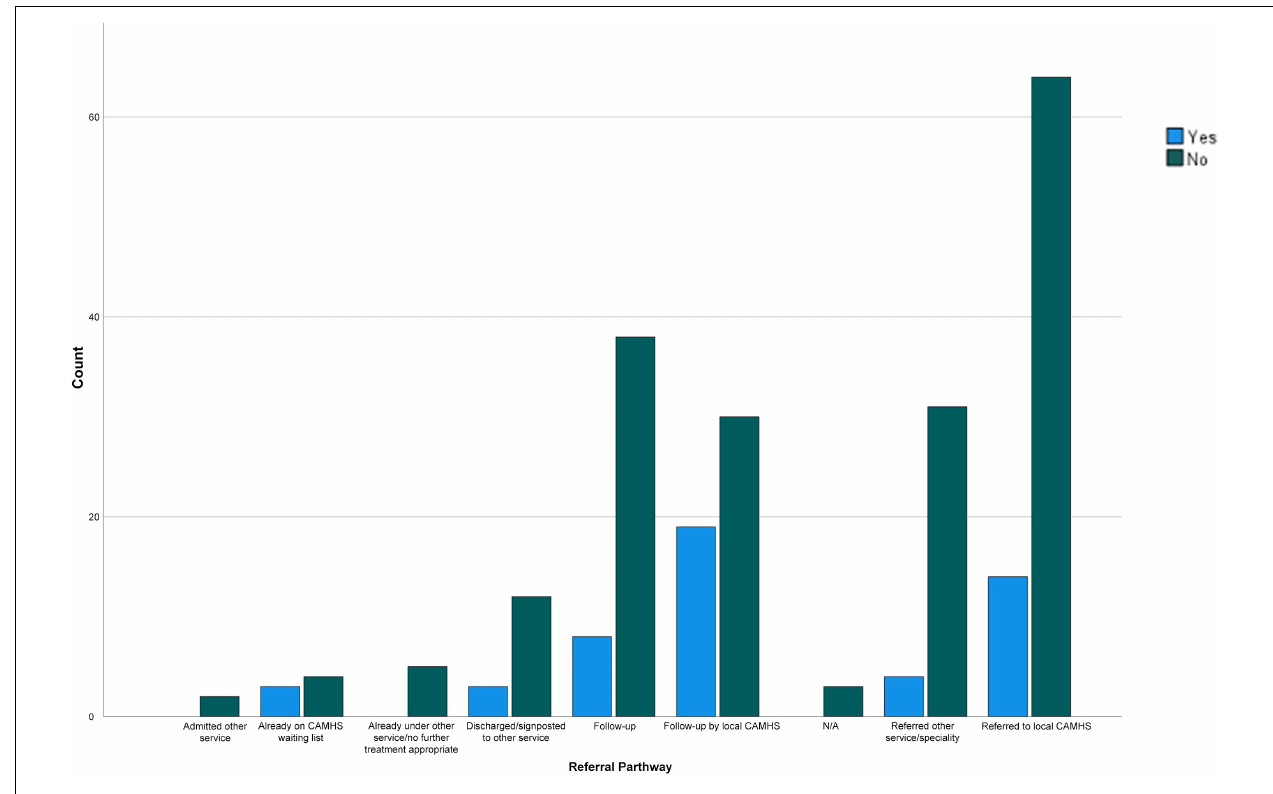
FIGURE 1 | Referral pathway following ED attendance for suicidal crisis and ASC traits.